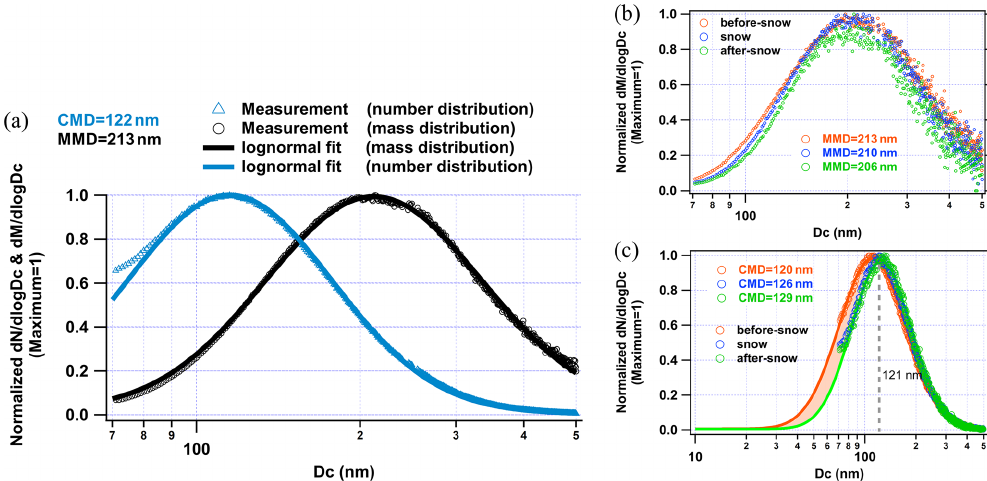
Figure 4. (a) Number and mass size distribution (d N/ dlog D c and d M/ dlog D c ) of r BC core during the whole campaign. (b) Mass size distribution (d M/ dlog D c ) during snowfall and (c) number size distribution (d N/ dlog D c ) during snowfall. Note that the orange and green lines in (c) are the log-normal fit of number size distribution during the before-snow and after-snow periods, respectively. And the orange shaded areas denote the difference in area between the two log-normal fit curves at D c less than